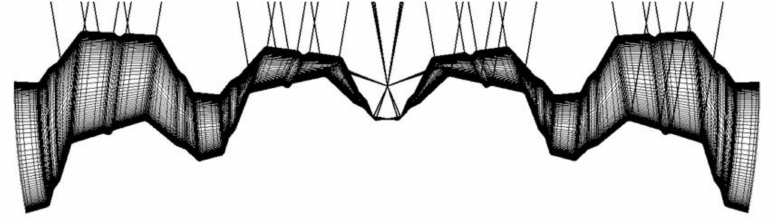
Figure 3. An exact computational folded model of a nominally plane folded sheet transformed into a shell